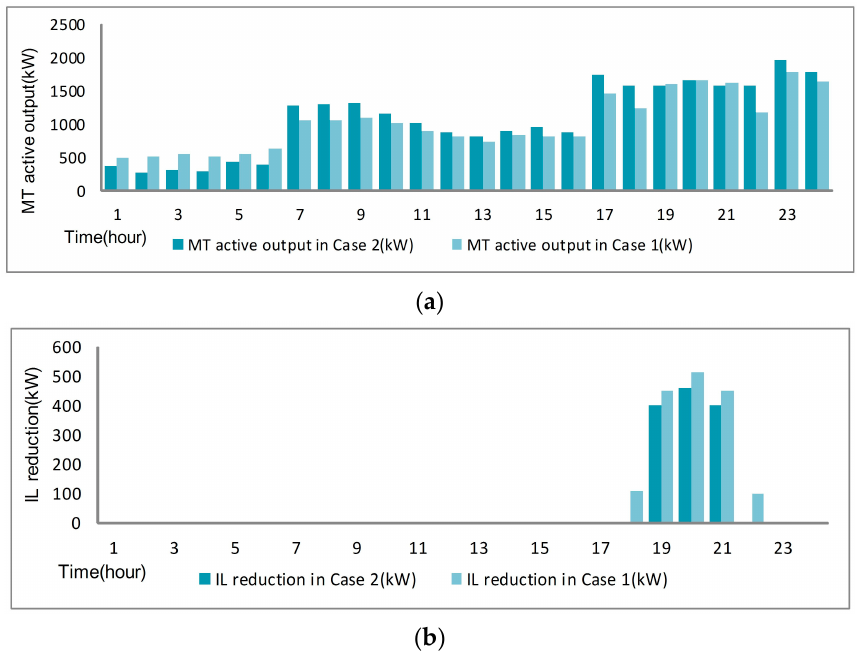
Figure 6. Comparisons of DER outputs in each hour between case 1 and case 2. ( a ) Comparison of MTs active power outputs in each hour between case 1 and case 2; ( b ) Comparison of ILs reduction in each hour between case 1 and case 2.